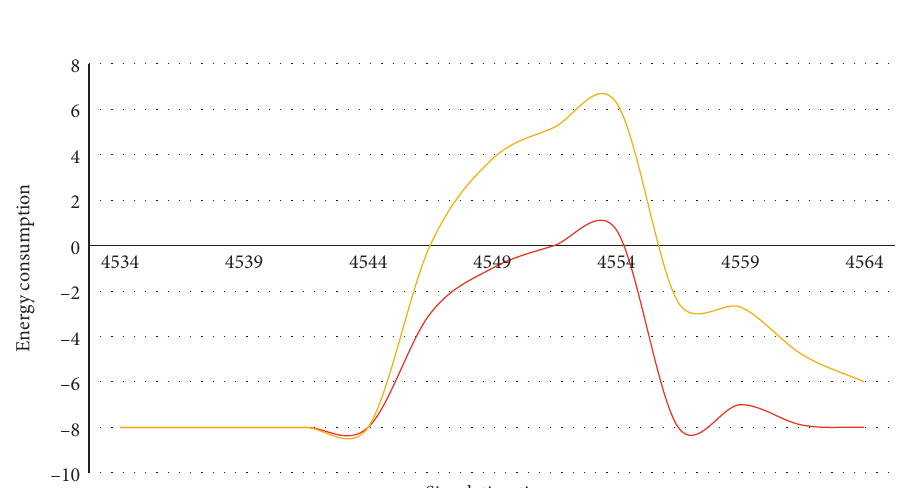
Figure 8: PMV output at 22 ° C.